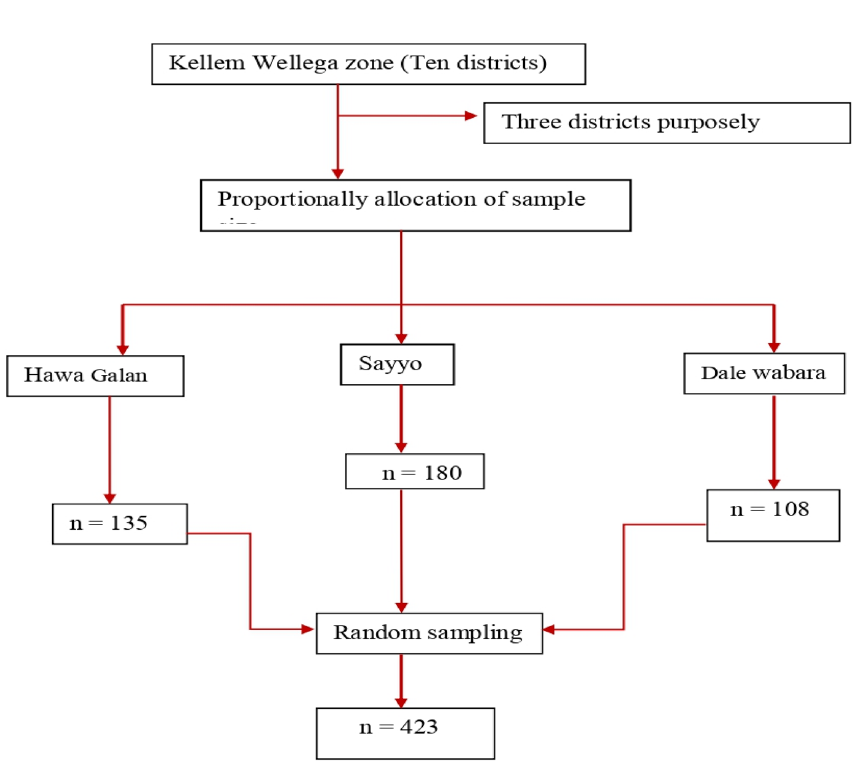
Figure 4. Schematic presentation of sampling techniques for pregnant women of Kellem Wellega zone in